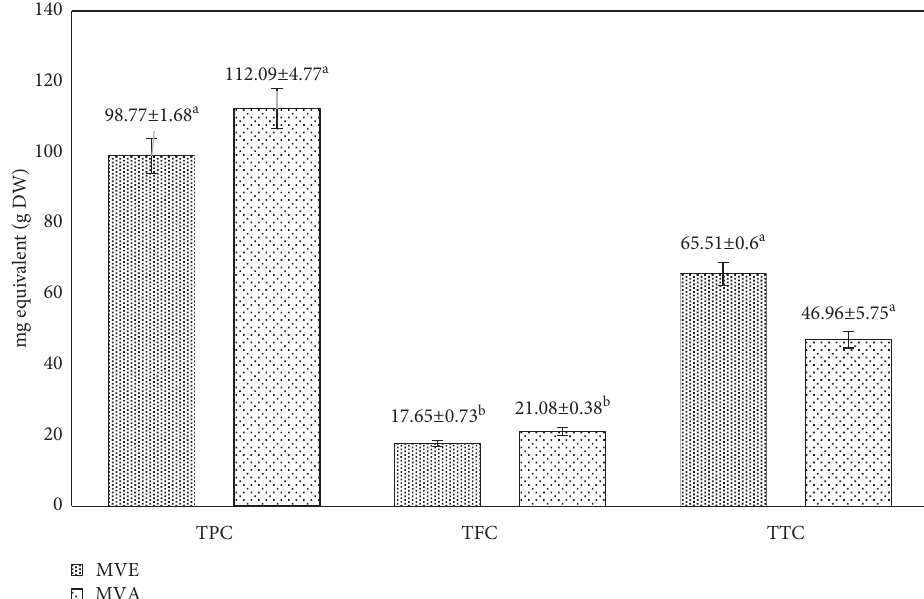
Figure 1: TPC, TFC, and TTC in mg (gallic acid, quercetin, and ascorbic acid, respectively) equivalent/gram dry weight of two extracts from Marrubium vulgare L . The results are expressed by means ± standard deviation, and values with different letters are significantly different ( P < 0 .